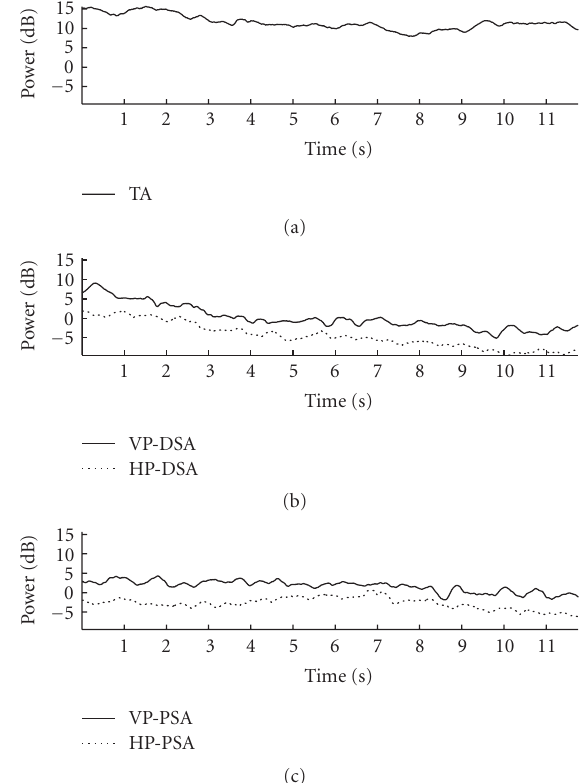
Figure 8: Received power measured at each array along Slater